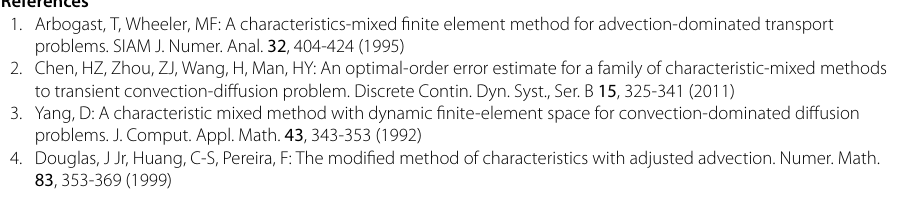
Table 2 The convergence rate for (cid:2) z – z h (cid:2) h = (cid:6)